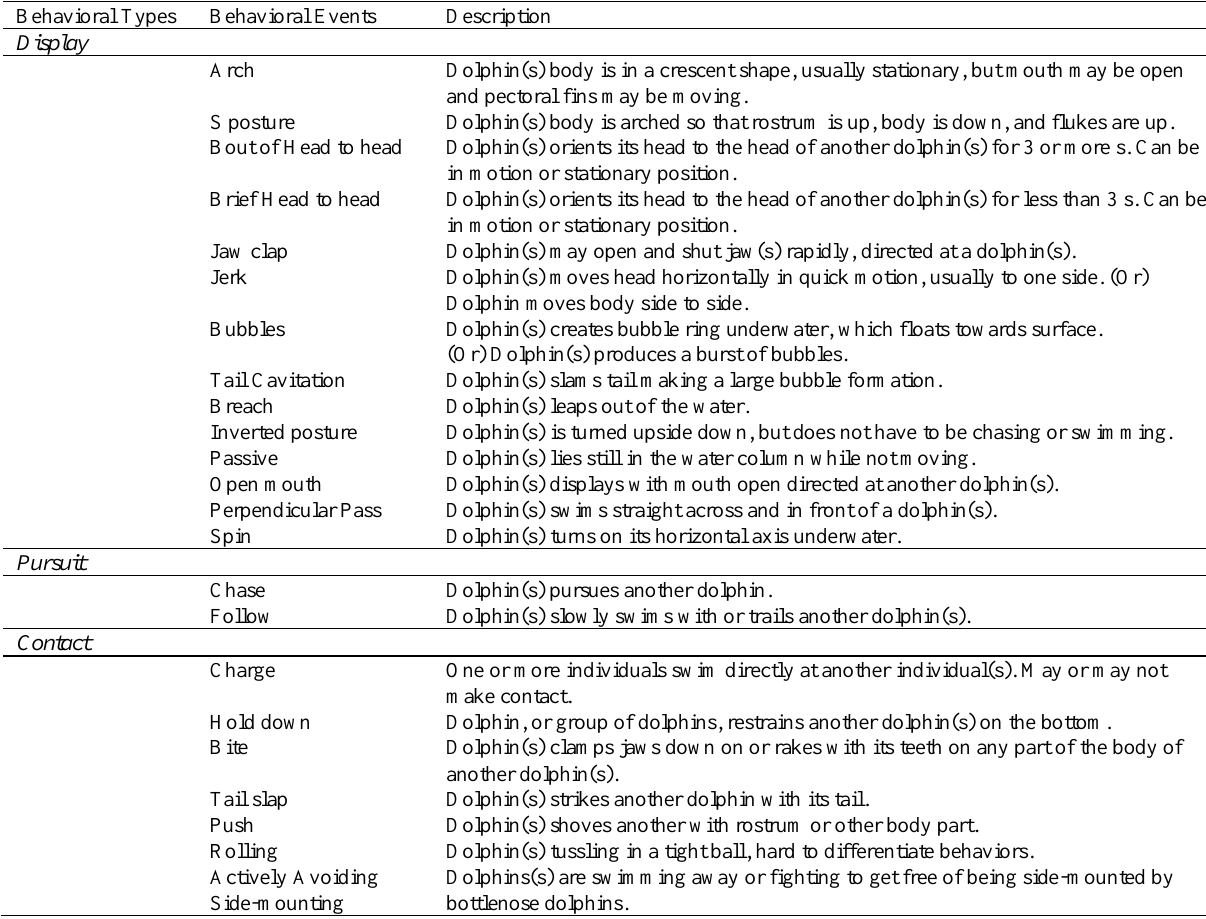
Behavioral Ethogram showing the Behavioral Types and Behavioral Events within those